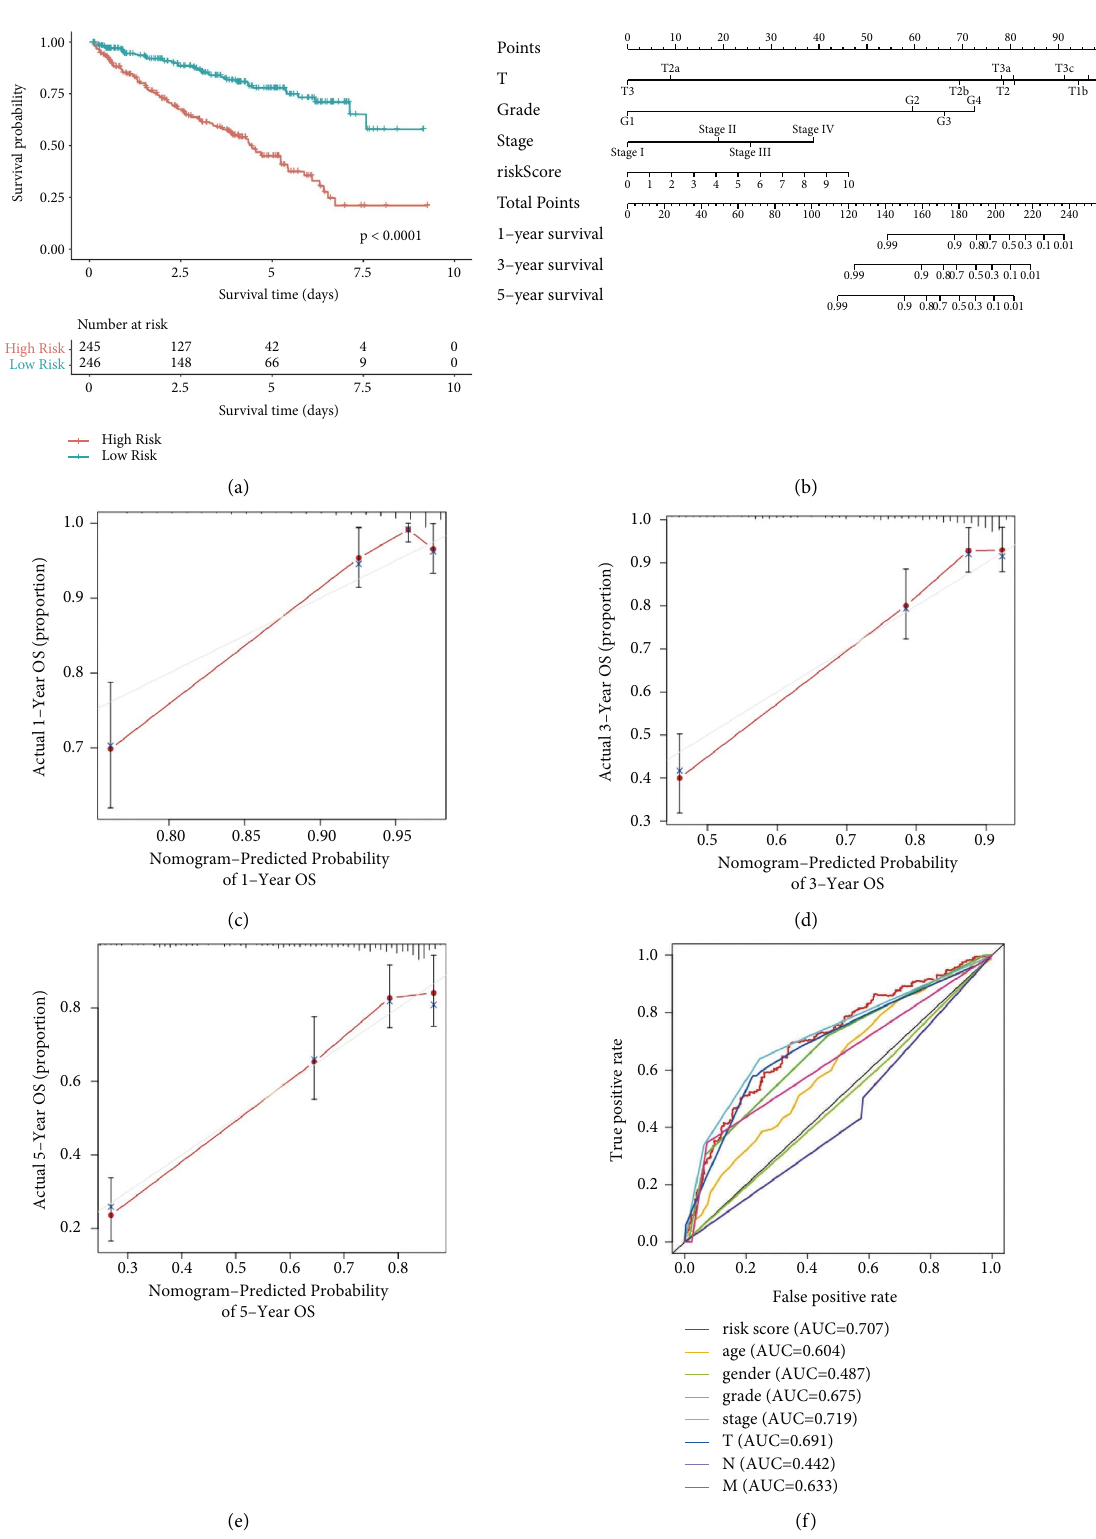
Figure 5: Analysis of the prognosis model. (a) Kaplan–Meier curves corresponding to the OS for high-risk and low-risk groups stratifed based on RS ( p < 0.0001). (b) A clinical prognostic nomogram was developed to predict 1 -year, 3 -year, and 5-year survival. Calibration curves showing nomographic predictions for 1-year (c), 3-year (d), and 5-year (e) survival. (f) Prediction of the 5-year OS based on the RS, age, sex, grade, stage, and TNM